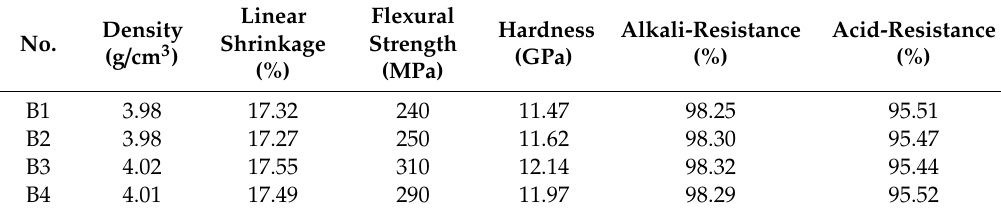
Table 3. Mechanical properties and corrosion-resistance of samples B1~B4.